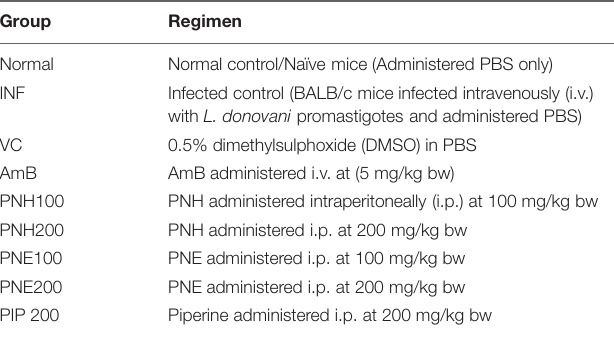
TABLE 1 | Experimental design for in vivo